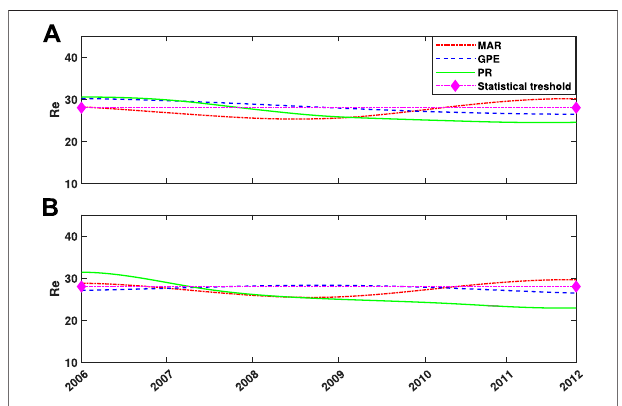
FIGURE 8 | Residual (Re) from (A) CEEMDAN and (B) ICEEMDAN for Martinique (MAR), Guadeloupe (GPE) and Puerto-Rico (PR) from 2006 to 2011. The horizontal purple dash-dot line represents the PM 10 statistical threshold estimated over 11 years at 28 μ g/m 3 .